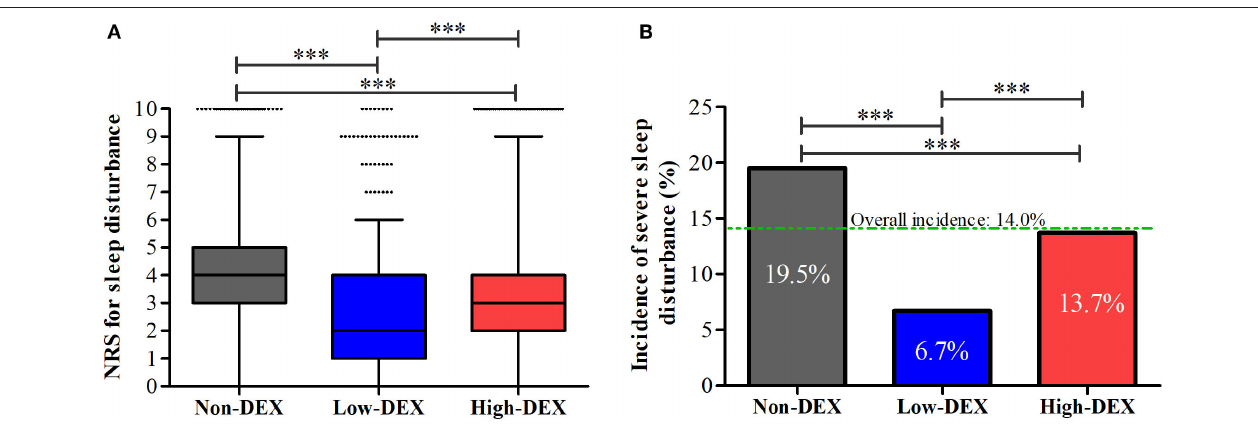
FIGURE 3 | NRS for sleep disturbance (A) and the incidence of severe sleep disturbance (B) during the first night after the surgery in the Non-DEX group ( n = 1,374), Low-DEX group ( n = 917), and High-DEX group ( n = 2,058) patients. *** P < 0.001; (A) box plot, interquartile range; solid line, median; whiskers, third quartile + 1.5* interquartile range; dots, abnormal value. (B) box,